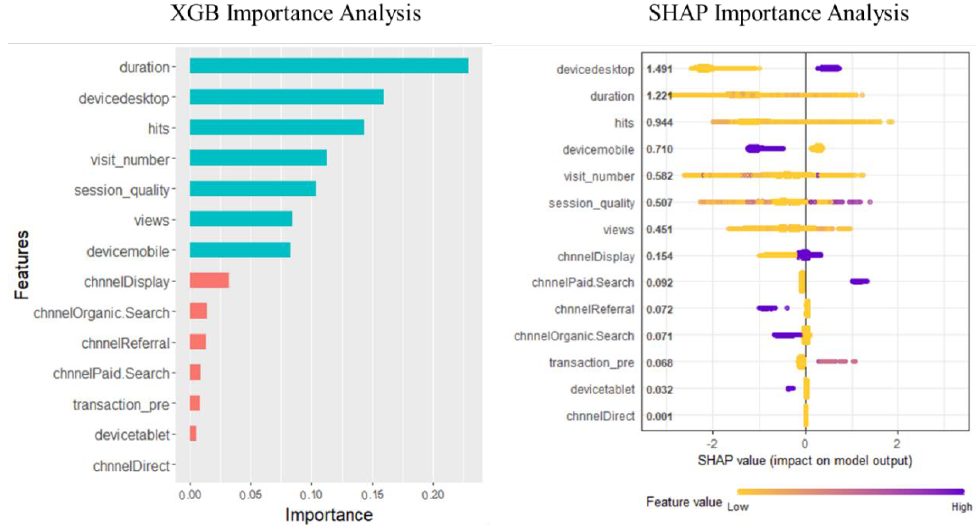
Figure 4. Analysis of the importance of variables.